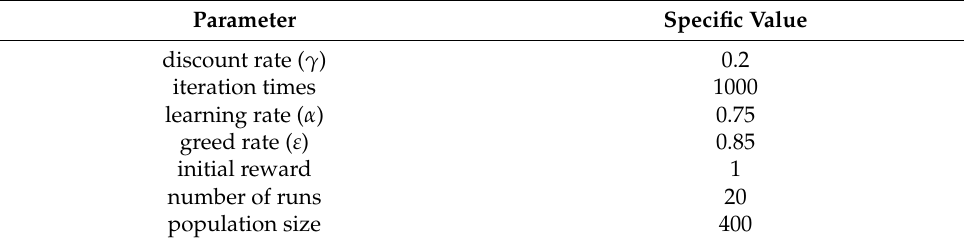
Figure 13. Experiment to determine iteration times. Table 7. The parameter values of the SLABC